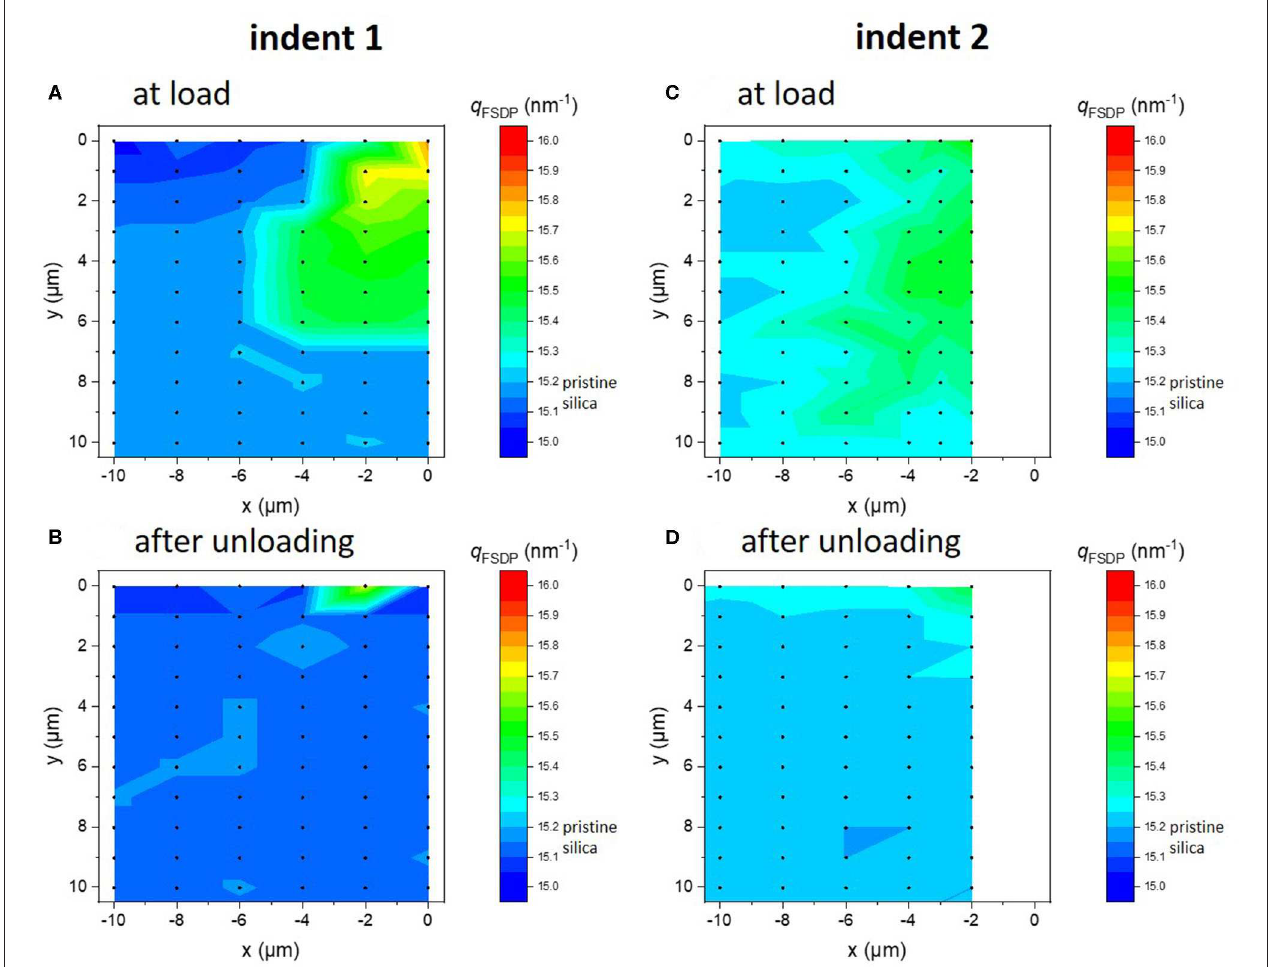
FIGURE 2 | Spatial variation of the maximum position of the First Sharp Diffraction Peak (FSDP), q FSDP , of vitreous silica monitored as function of depth relative to the sample surface, y , and for different distances relative to the diamond tip, x . Black points indicate points of data acquisition. The color map was obtained from linear interpolations between data points. Data were recorded during loading (A,C) with a wedge-shaped diamond tip, as well as directly after unloading (B,D)